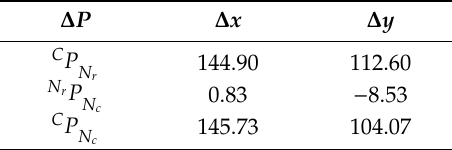
Table 3. Estimated displacement vectors